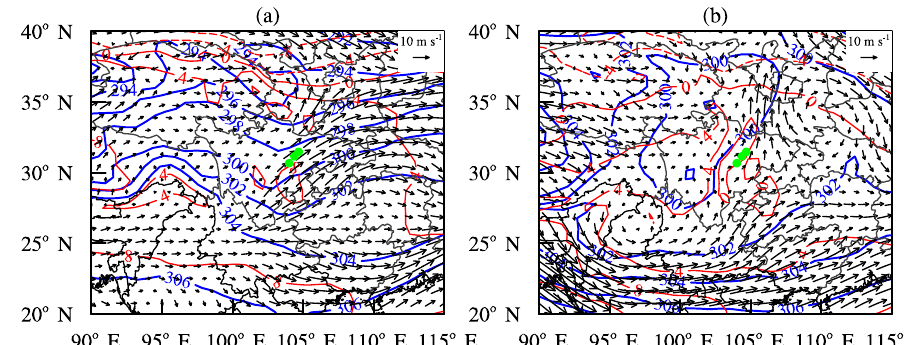
Figure 2. Weather maps at 700hPa based on ERA-Interim daily data showing (a) a trough from event 2 at 20:00BST on 28 January 2006 and (b) a low vortex from event 4 at 14:00BST on 22 December 2007. The blue lines are isopleths of geopotential height, the red lines are isotherms, and the black arrows are wind vectors. The green dots show the location of the urban agglomeration.